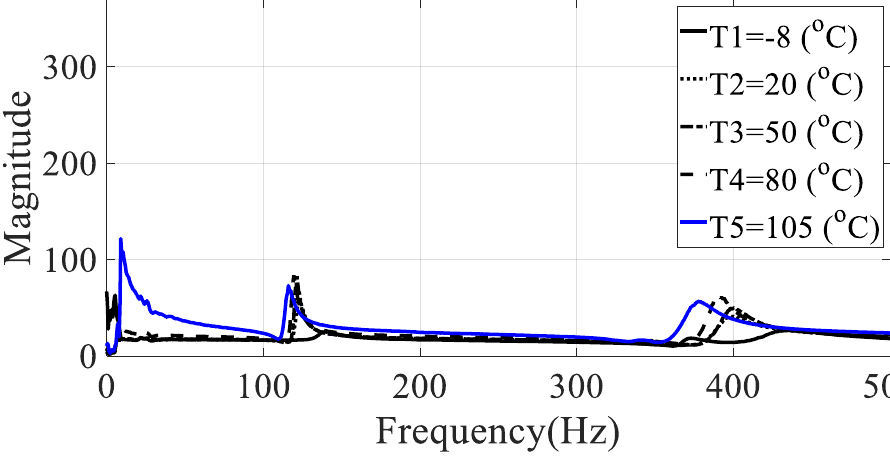
Figure 6. Representative frequency response function of specimen II ( φ = 30 degrees ).